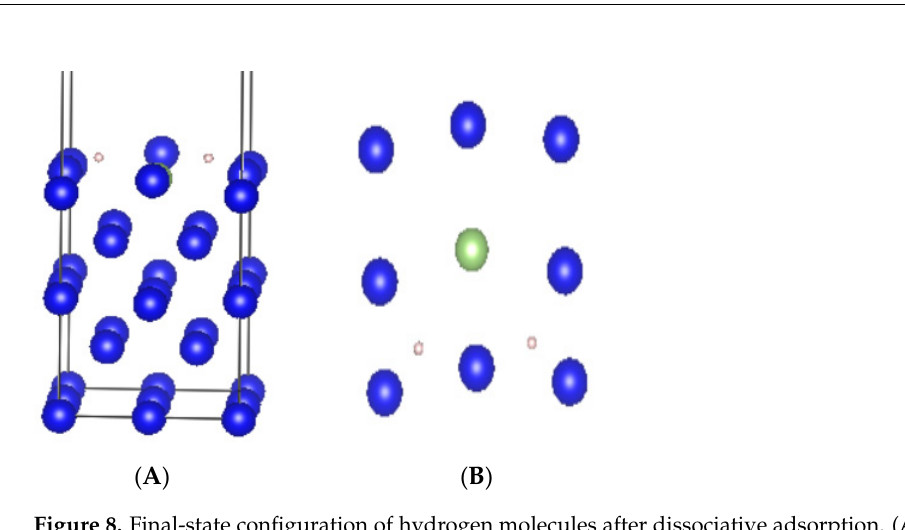
Figure 8. Final-state configuration of hydrogen molecules after dissociative adsorption. ( A ) standard orientation of crystal shape ( B ) top view.